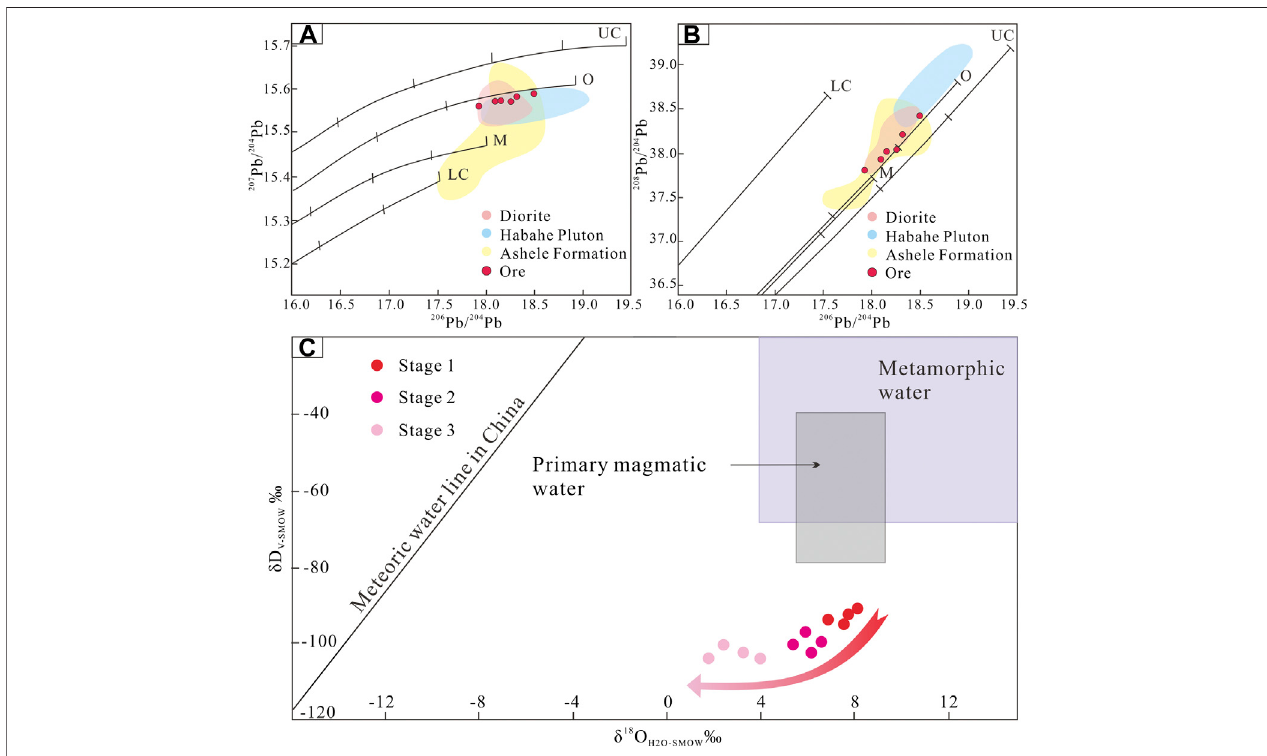
FIGURE 8 | (A ) 207 Pb/ 204 Pb vs. 206 Pb/ 204 Pb plot and (B) 208 Pb/ 204 Pb vs. 206 Pb/ 204 Pb plot for sul fi des in the Jinba gold deposit and associated host rocks. The average growth curve is from Zartman and Doe (1981). (C) Diagram showing δ D vs. δ 18 O for quartz, representing different stages of mineralization in the Jinba gold